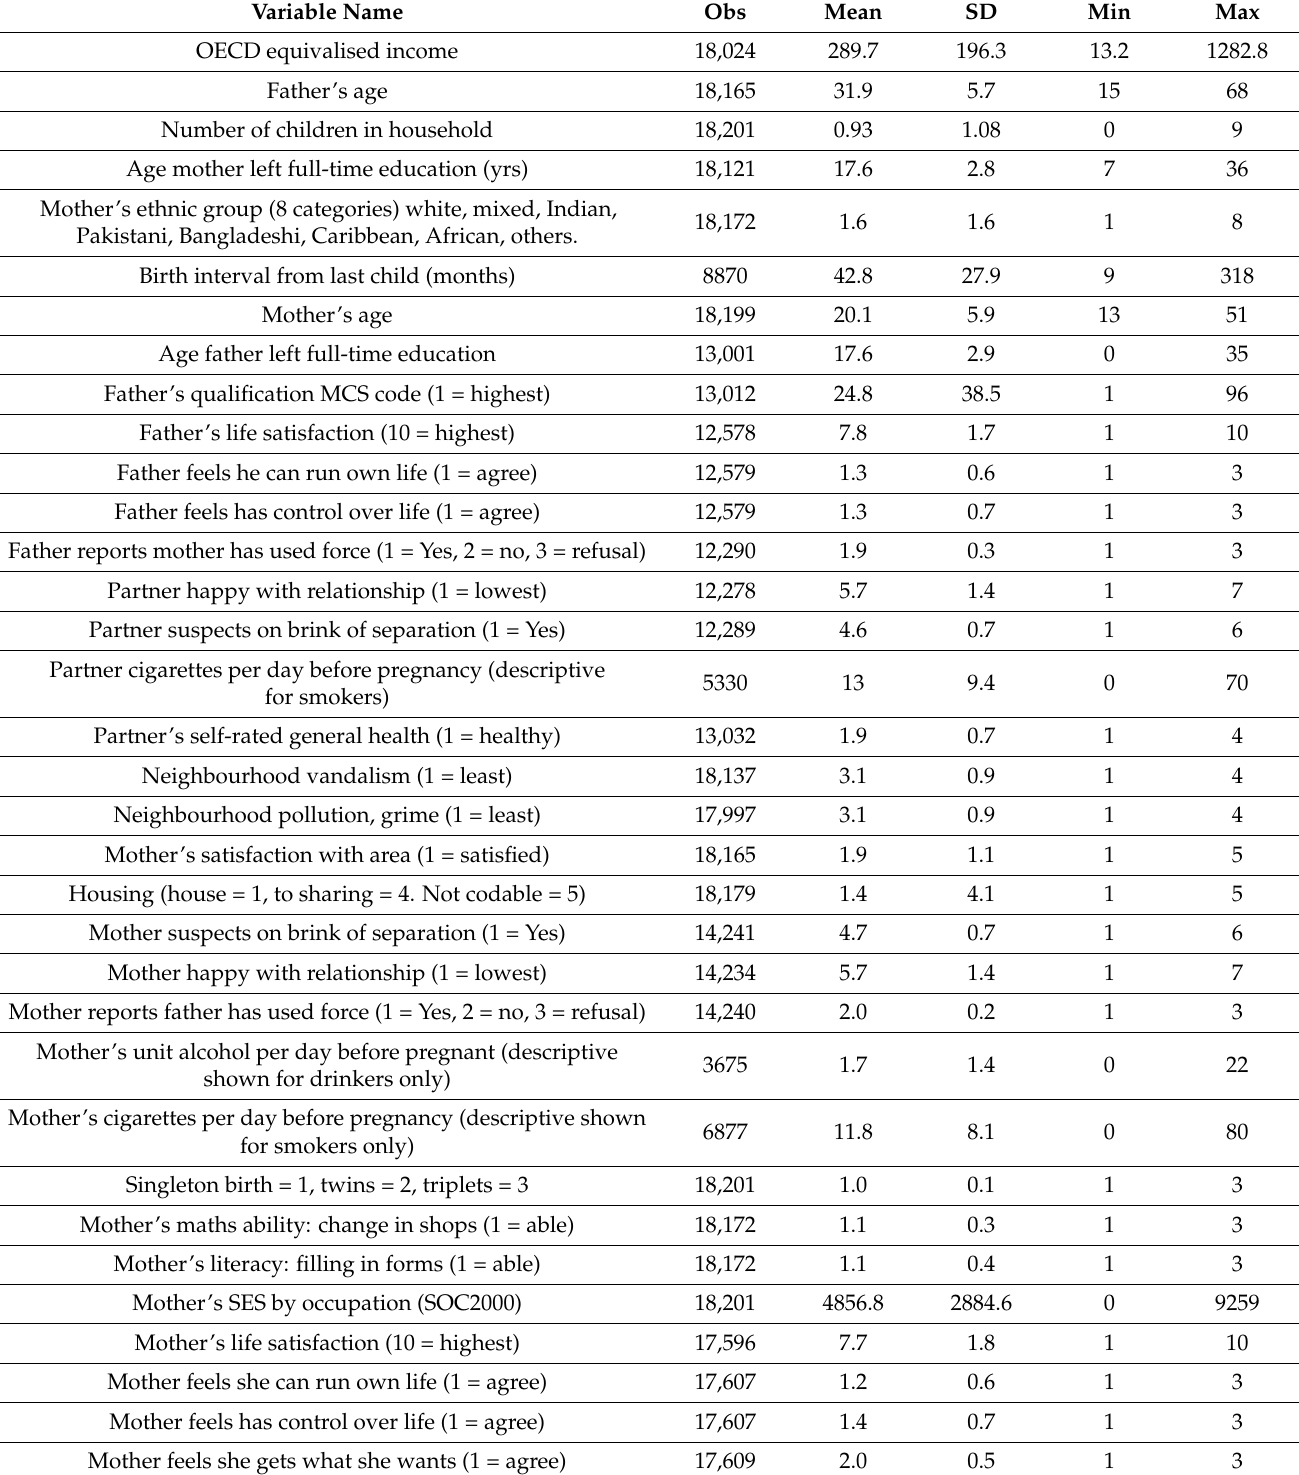
Table 2. Descriptive statistics (non-binary